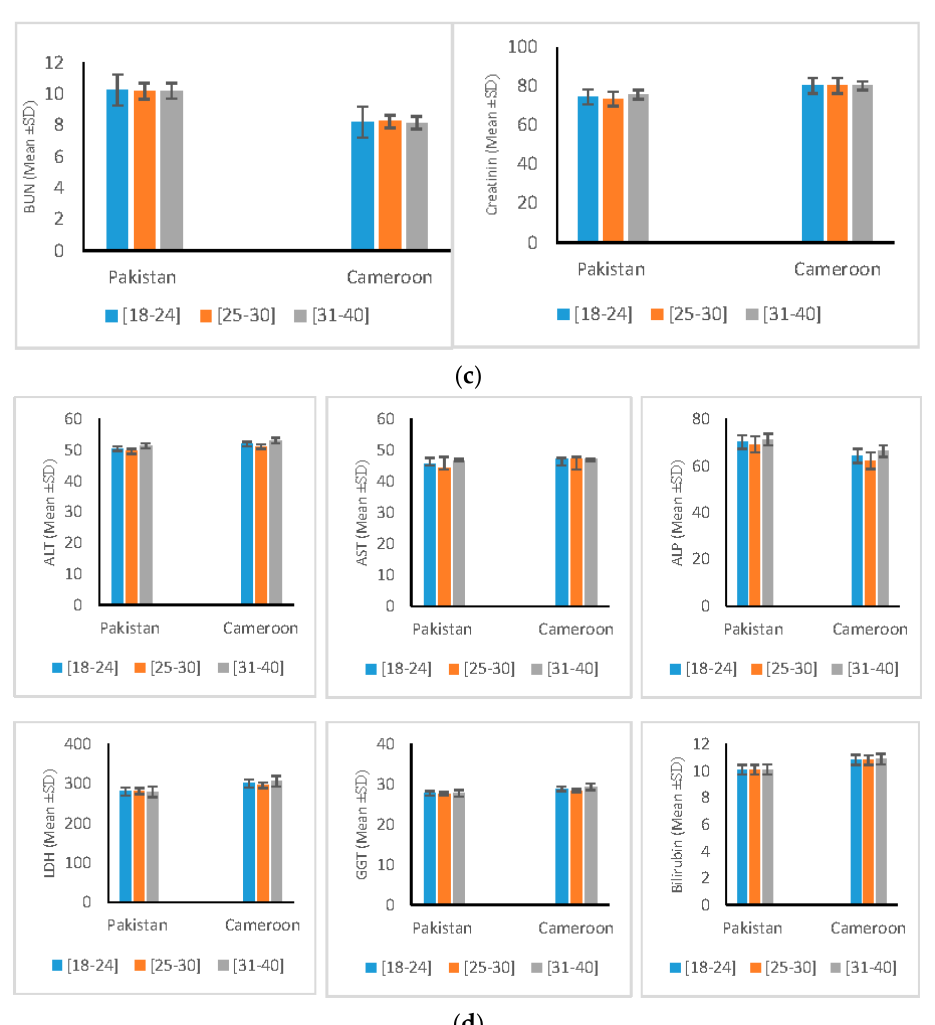
Figure 3. Variation of Biochemical Profile according to age groups, ( a ) Variation of Lipid Profile Parameters according to age group, ( b ) Variation of Diabetic Related Variables Stratified according to age group, ( c ) Variation of Kidney Function Parameters according to age group, ( d ) Variation of Hepatic Function Profile p according to age group.